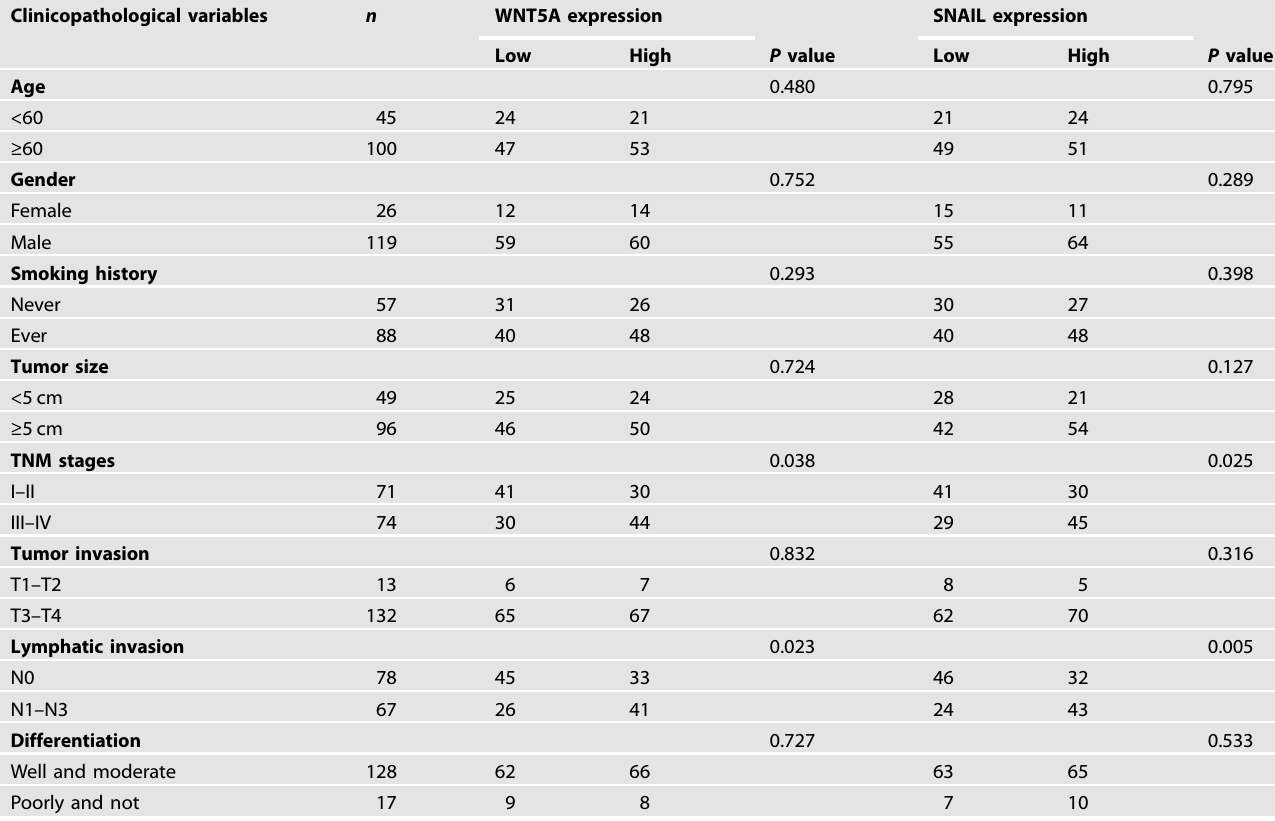
Fig. 1 High WNT5A expression in ESCC tissues is correlated with a poor prognosis. A Representative IHC images showing WNT5A expression in ESCC tissues. Scale bars, 200 and 50 μ m (inset). B Statistical analysis of WNT5A expression in 145 patients with ESCC based on the IHC results from the tissue microarray. C Kaplan – Meier survival analysis of 145 patients with ESCC presenting high/low WNT5A expression. Table 1. Correlations of WNT5A and SNAIL expression with the clinicopathological characteristics of patients with